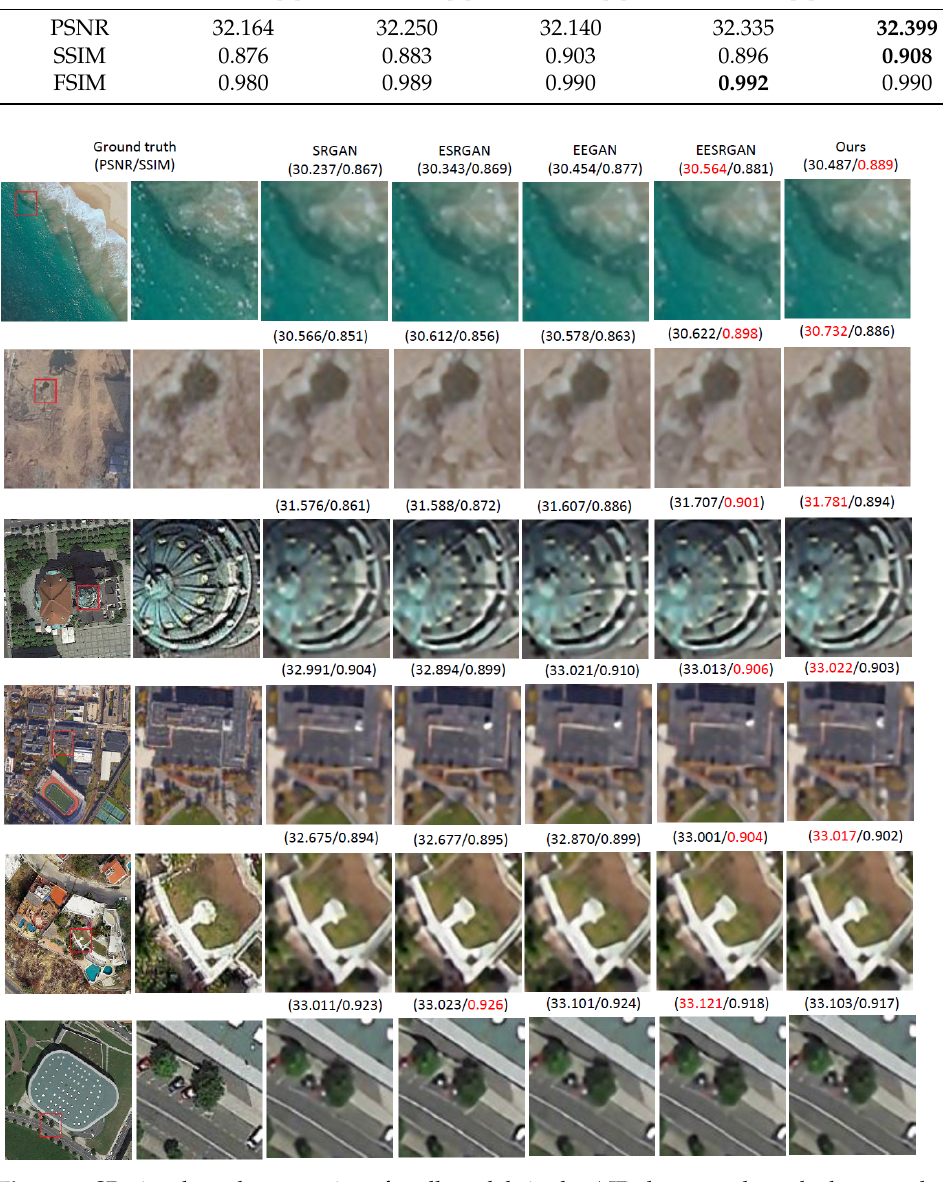
Figure 9. SR visual result comparison for all models in the AID dataset, where the best results are shown in red